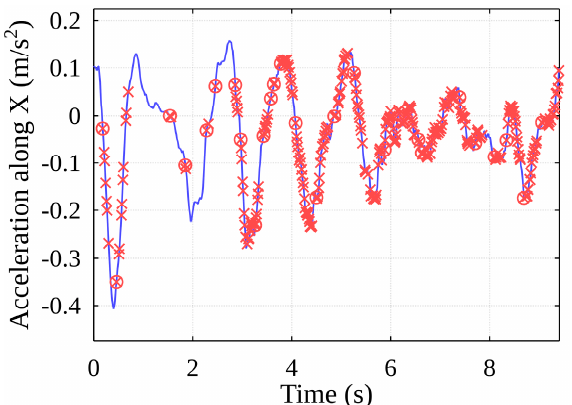
Figure 20. Event peaks are filtered after another threshold value is